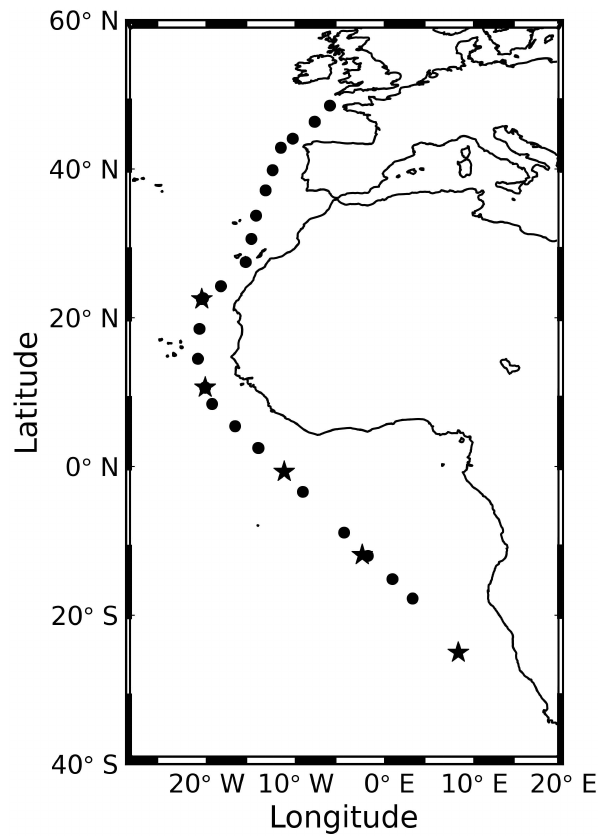
Fig. 1. Geographic positions of relevant sampling stations during the cruises ANT-XXIII/1 (November 2005) and ANT-XXV/1 (November 2008). Shown are the positions of regular sampling stations (solid circles) and those of the five stations at which the whole water column was sampled